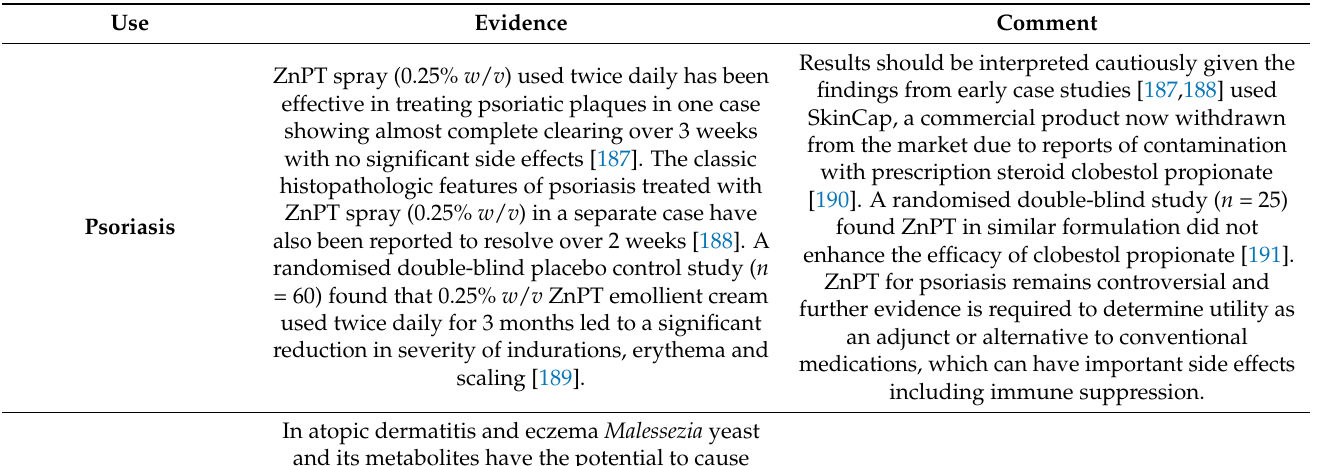
Table 5. Therapeutic re-purposing of zinc